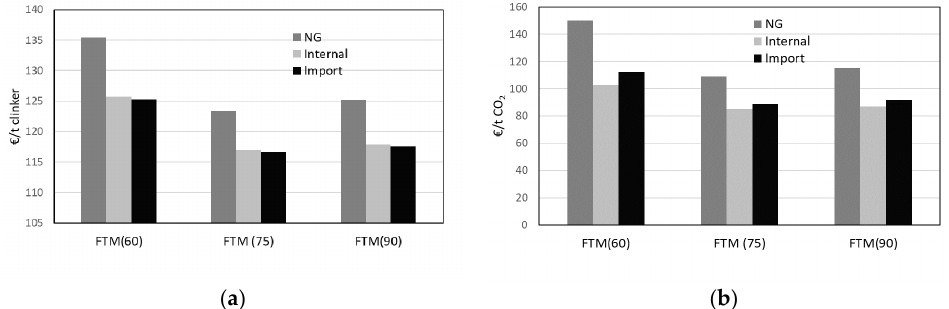
Figure 5. Comparison of economic performance of FTM processes for the three different steam scenario at three different temperatures: ( a ) Cost of Clinker ( € /ton clinker); ( b ) CO 2 avoidance Cost ( € /ton CO 2 ). Table 5. Comparison of different carbon capture